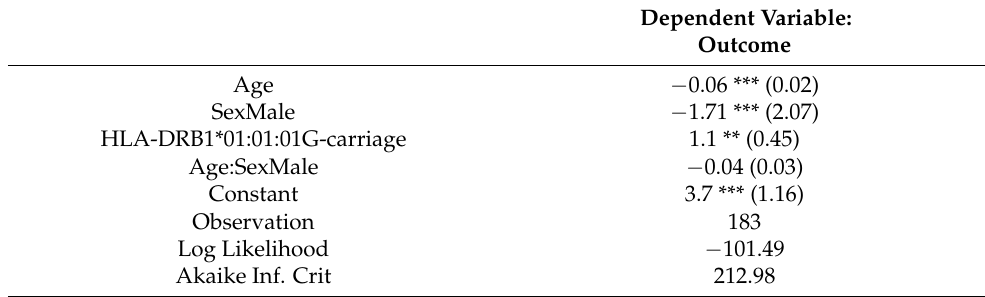
Table 13. Coefficients for one-allele (HLA-DRB1*01:01:01G) model.